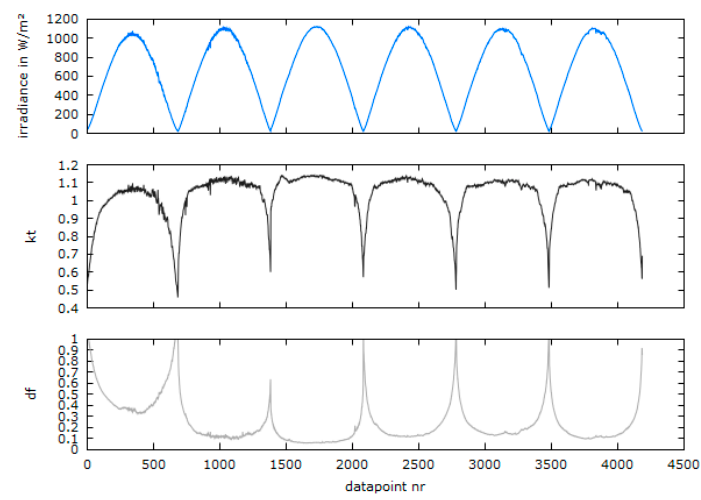
Figure 8. Measurement values for global irradiance (blue, top ), kt (black, center ) and df (grey, bottom ) for Tamanrasset, Algeria, from 21 to 26 March 2006. This plot illustrates the variation of the minimum daily df value ( df min ) for consecutive clear sky days. df min values for March 21 to 26 are: 0.328, 0.101, 0.062, 0.123, 0.139 and 0.105. One factor of influence seems to be the averaged maximum